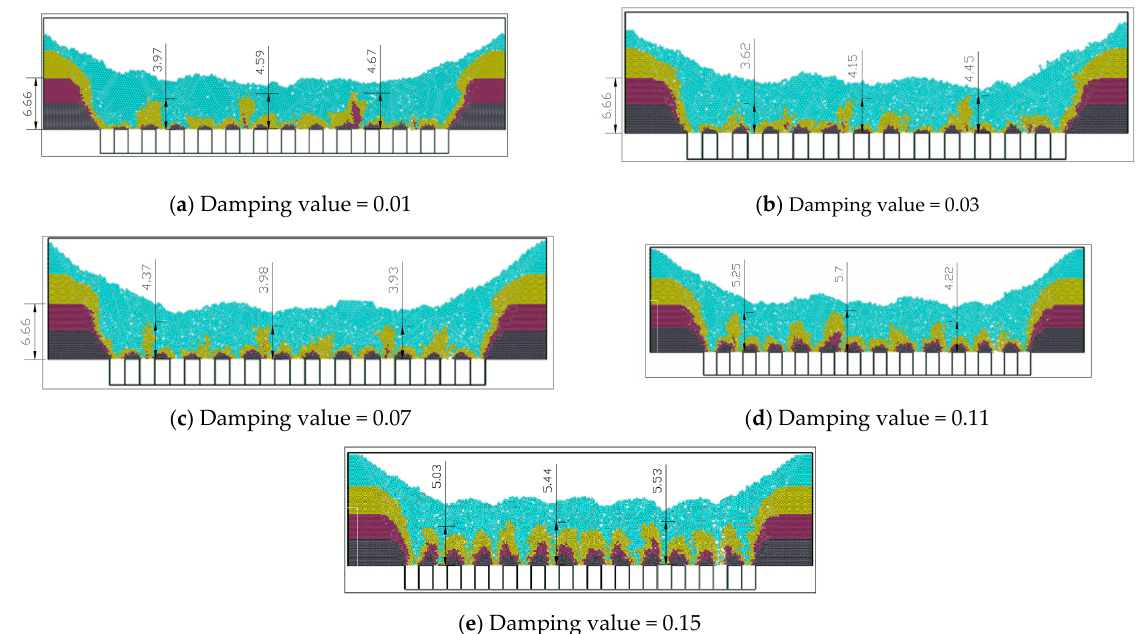
Figure 7. Results of coal-rock interface of Level 3 under different damping values (The unit in the picture is meter).